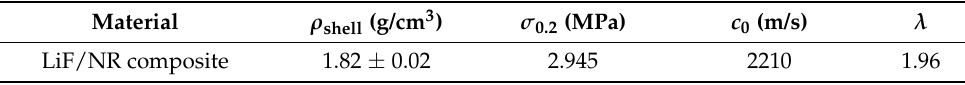
Table 2. The characteristics of the investigated LiF/NR composite.